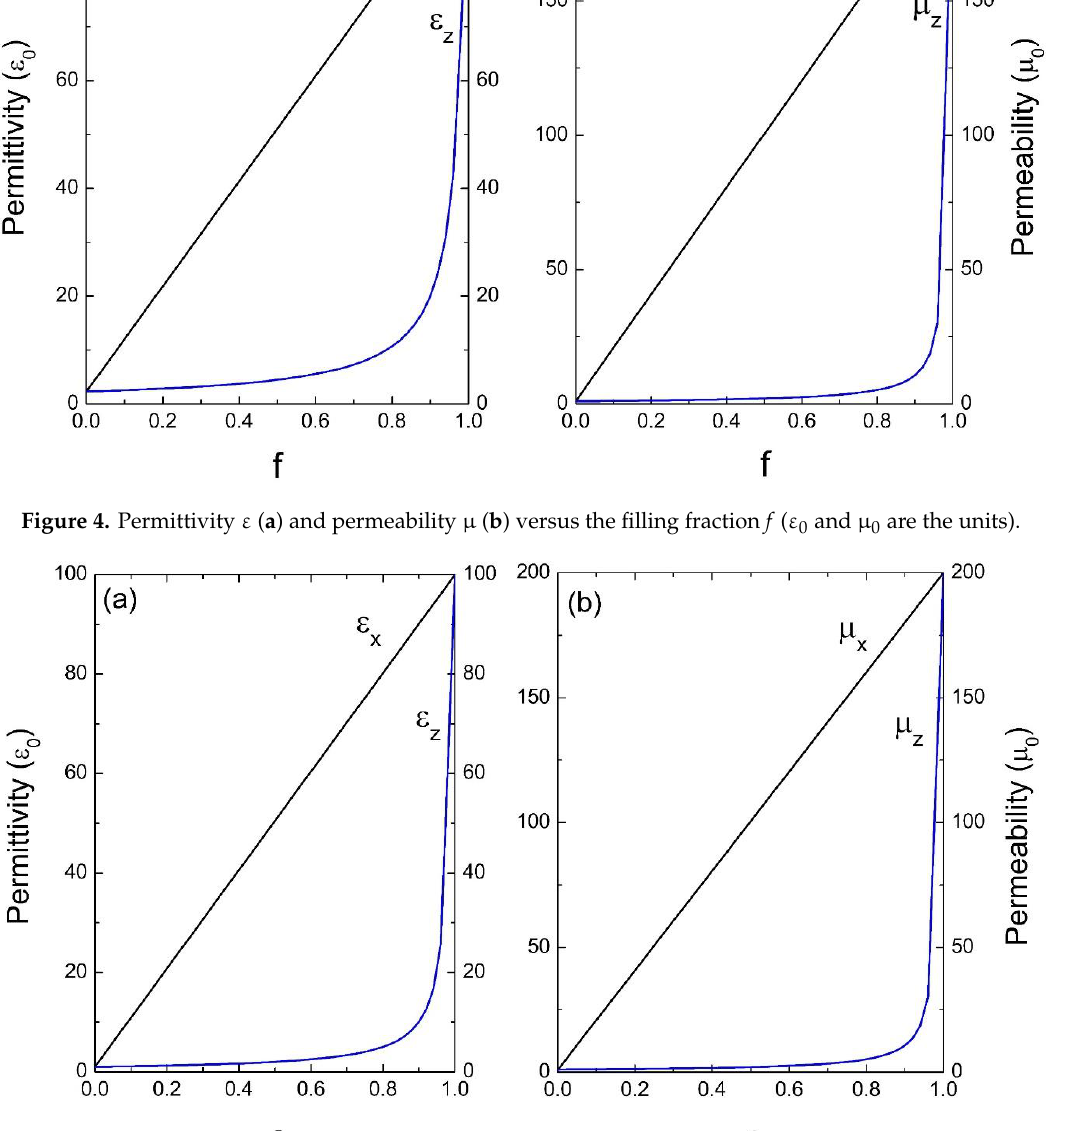
0 and μ 0 are the